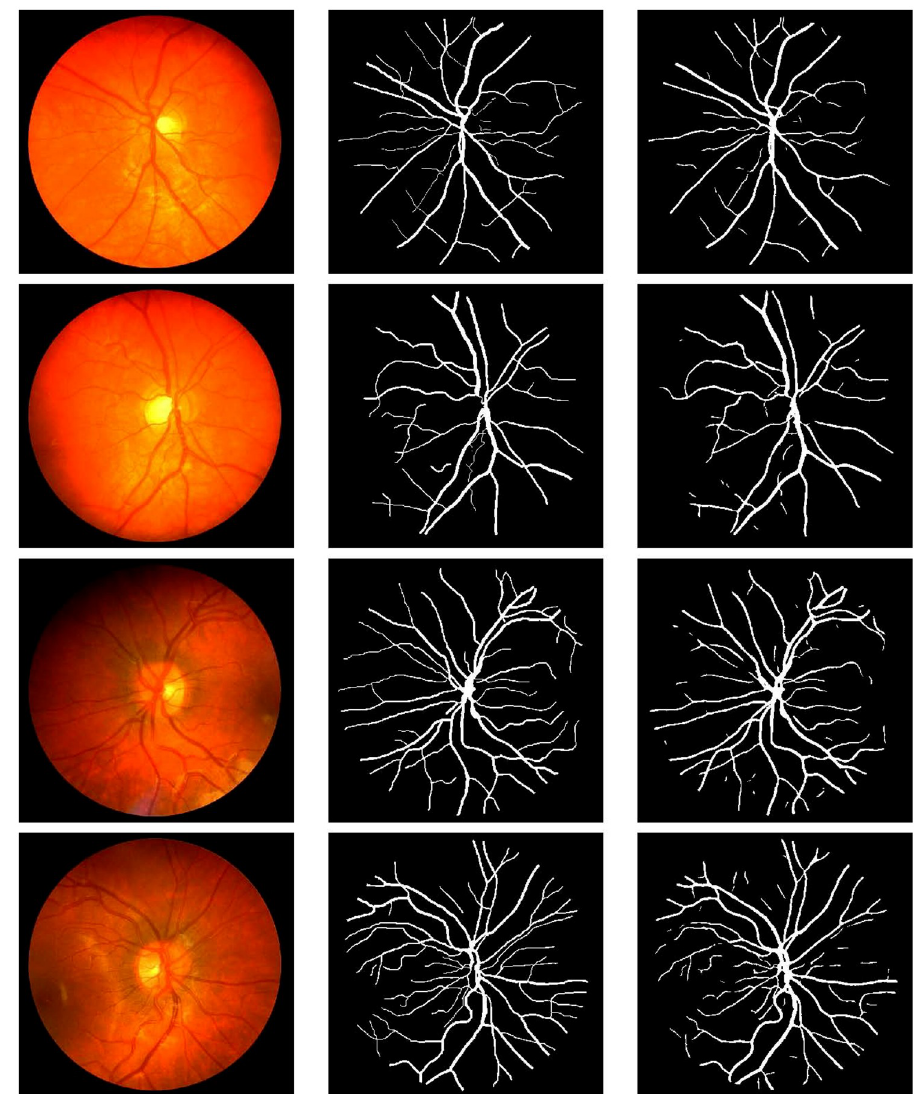
Fig 4. Visual results on the CHASE_DB1 dataset. From left-to-right: input images, ground truth, result obtained by our proposed method.